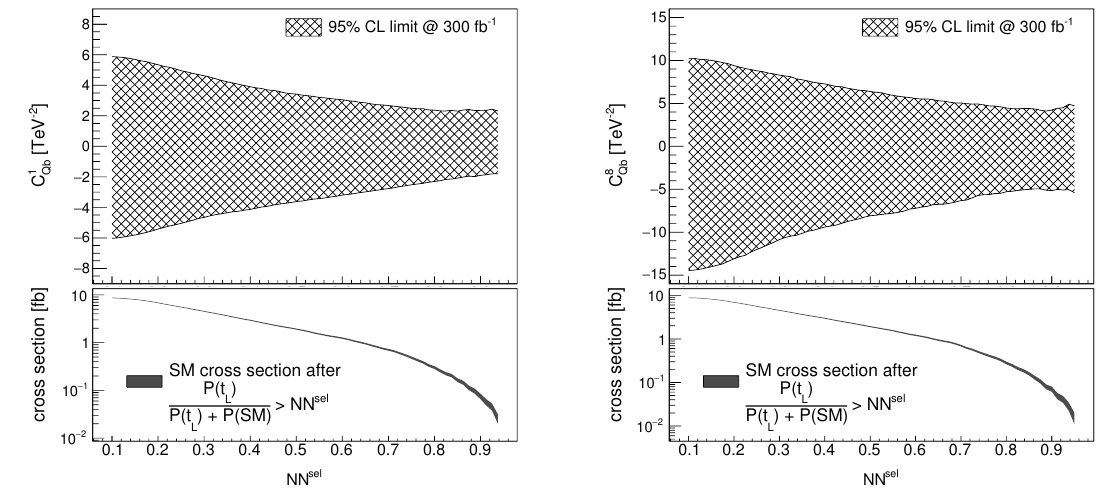
Figure 10 . Limits at 95% CL on C 1 (left) and C 8 (right) as a function of the threshold on the Qb Qb network output. In the bottom panels, the e(cid:11)ective (visible) SM cross section as a function of the NN output threshold is shown, with the corresponding statistical uncertainty shown as a grey band.